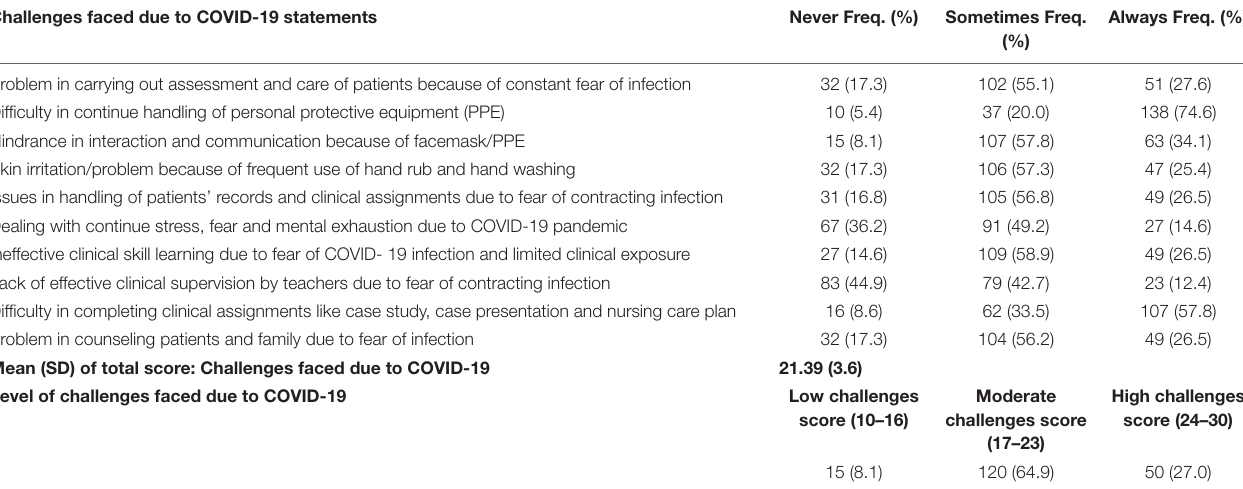
TABLE 3 | Participants’ challenges faced due to